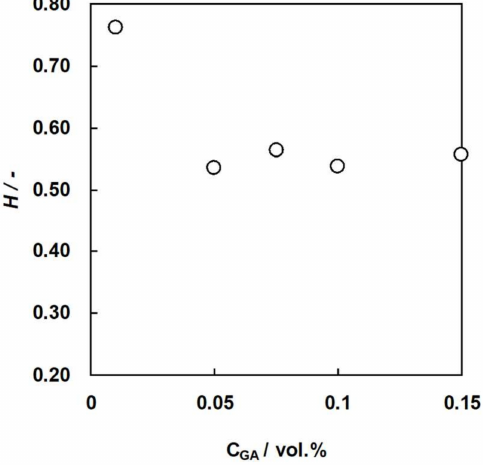
Figure 10. Water content, H , of A-HF membranes as a function of GA